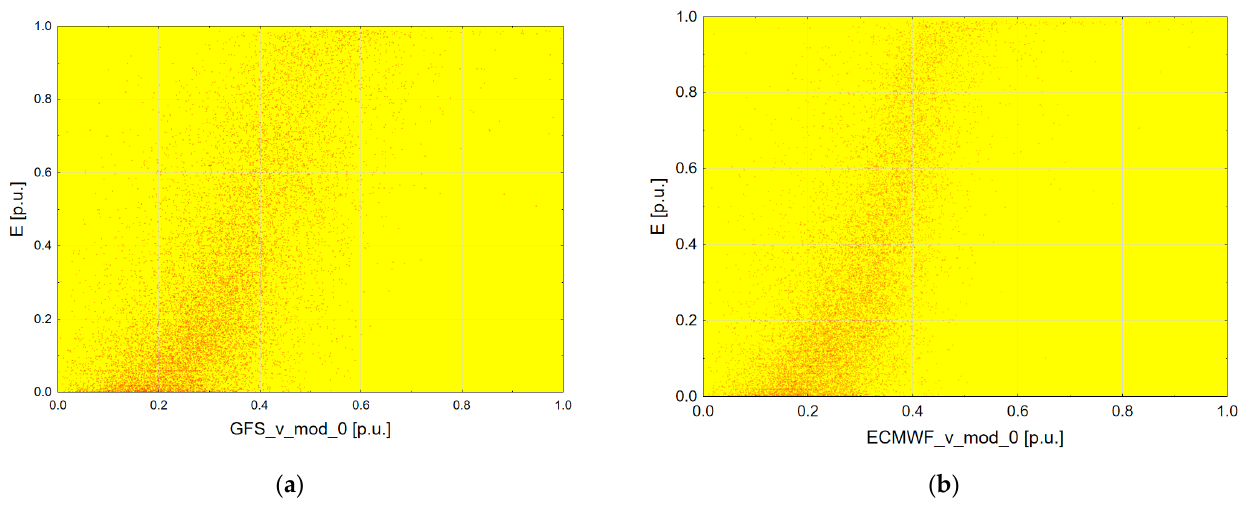
Figure 6. ( a ) Relationship between wind speed forecast from GFS NWP model and electricity generation from Wind Farm A; ( b ) Relationship between wind speed forecast from ECMWF NWP model and electricity generation from Wind Farm A.